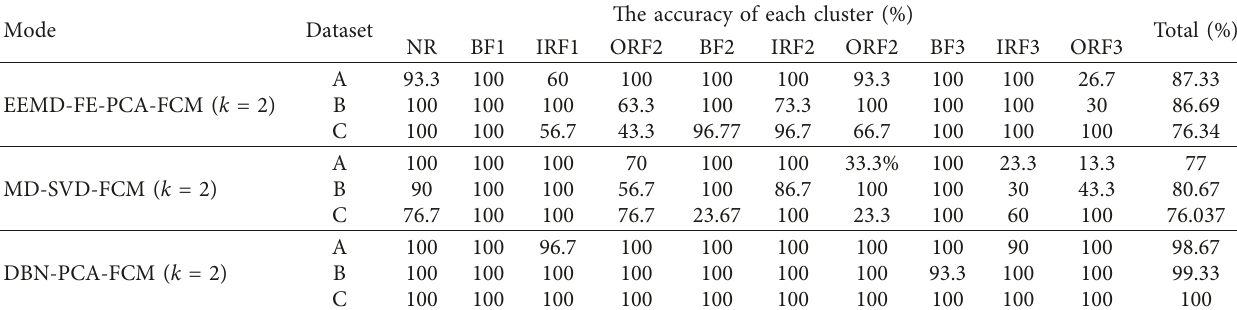
Table 5: The results of classification